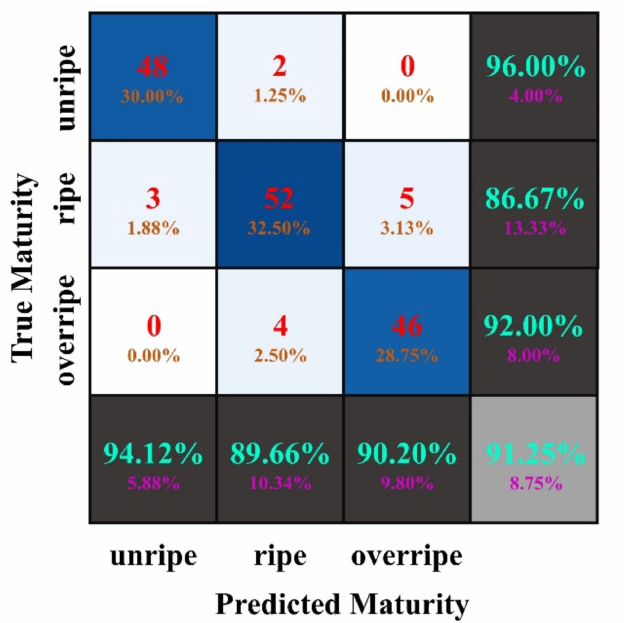
Figure 6. Confusion matrix for identification Camellia oleifera fruit maturity in the testing